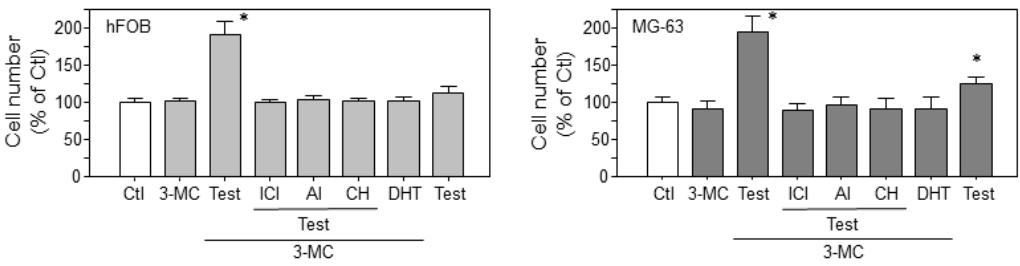
Figure 5. Cell proliferation effects of AhR agonists through the aromatase pathway. Co-treatment with testosterone and 3-MC (10 μ M) significantly increased cell numbers of both hFOB and MG-63 cells. * p < 0.05; Ctl, vehicle control (0.005% dimethyl sulfoxide); 3-MC, 10 μ M 3-methylcholanthrene; BPA; Test, 10 nM testosterone; ICI, 10 μ M ICI 182,780; AI, 10 μ M Aromatase Inhibitor I; CH, 10 μ M CH-223191; DHT, 10 nM dihydrotestosterone. Data are presented as mean and standard deviation ( n = 6).